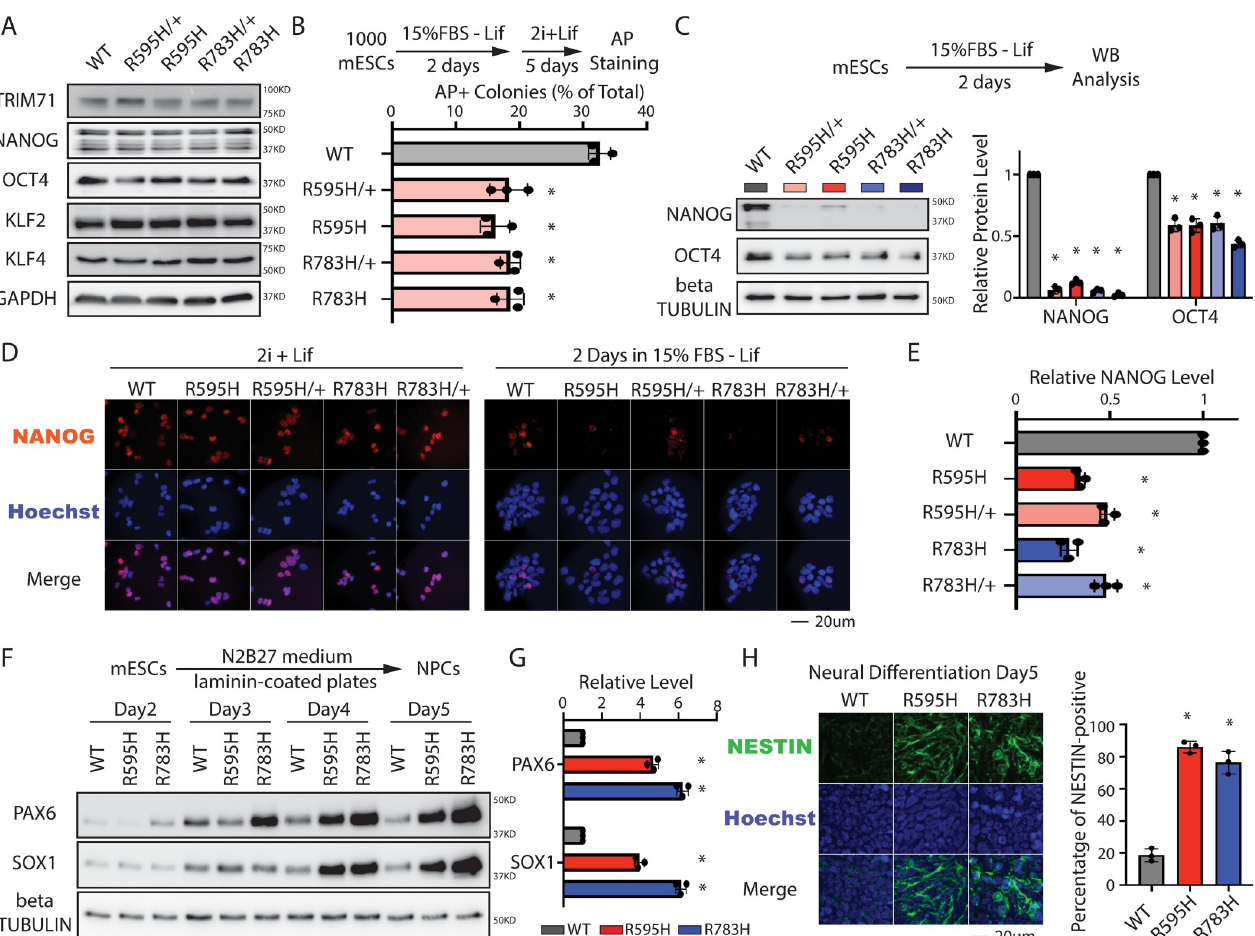
Fig 1. The two CH-associated mutations in Trim71 cause similar differentiation defects in mESCs. ( A ) Western blotting in the WT mESCs and mESCs with the CH-associated mutations in Trim71. The cells were cultured in the 2i + Lif medium. ( B ) Exit pluripotency assay for mESCs. The mESCs were induced to exit pluripotency in medium without Lif for 2 days and then switched to 2i+Lif medium for 5 days. The resultant colonies were fixed and stained for AP. The colony morphology and AP intensity were evaluated through microscopy. To AU : PleasenotethatasperPLOSstyle ; numeralsarenotallowedatthebeginningofasentence : Pleasecheckandconfirmthattheeditstothesentence } Todeterminethepercentageofundifferentiatedcolonies ; 100 (cid:0) 200 colonies ::: } arevalid ; andamendifnecessary : determine the percentage of undifferentiated colonies, 100–200 colonies were examined each time. The results represent the means ( ± SD) of three independent experiments. ( C ) Western blotting of pluripotency factors during the spontaneous differentiation of mESCs. ( D ) IF staining of NANOG in mESCs cultured in the stemness (2i + Lif) and differentiating (15% FBS–Lif) conditions. ( E ) Relative intensity of IF NANOG signals from individual cells in the differentiating condition. ( F ) Expression of neural lineage markers during the directed neural differentiation. ( G ) Quantification of Pax6 and Sox1 protein level at the neural differentiation Day5. ( H ) IF staining of Nestin. The quantifications represent the means ( ± SD) of three independent experiments. In C, F, and G, representative western blots are shown, and the quantifications represent the means ( ± SD) of three independent experiments. � p < 0.05; and n.s. not significant ( p > 0.05) by one-way ANOVA. See also S1–S4 Figs. The data for B, C, E, G, and H are available in S1 Data. CH AU : AbbreviationlistshavebeencompiledforthoseusedinFigs 1 (cid:0) 8 ; attheendofeachfigurecaption : Pleaseverifythatallentriesarecorrect : , congenital hydrocephalus; IF, immunofluorescence; mESC, mouse embryonic stem cell; WT, wild-type.